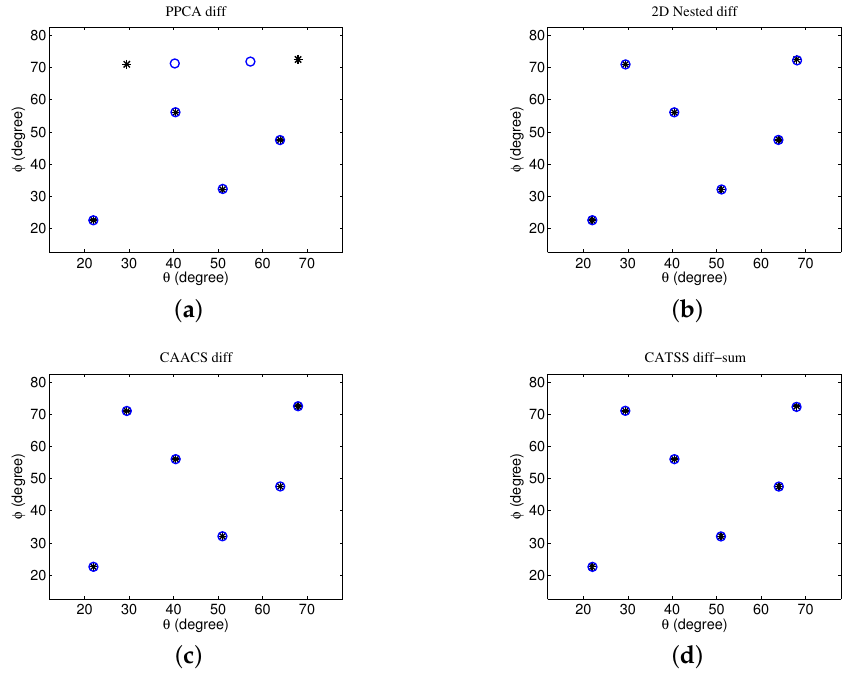
Figure 10. The estimated 2D direction-of-arrivals (DOAs) (denoted by ◦ ) and the true 2D DOAs (denoted by ∗ ) for ( a ) the difference coarray of prototype planar coprime array (PPCA), ( b ) the difference coarray of 2D nested array, ( c ) the difference coarray of CAACS, and ( d ) the diff-sum coarray of CATSS. The SNR is 0 dB. The number of snapshots is K =